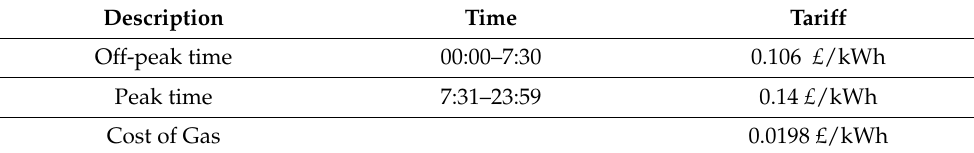
Table 5. Daily Time of Use (ToU) Electricity Tariff/Cost of